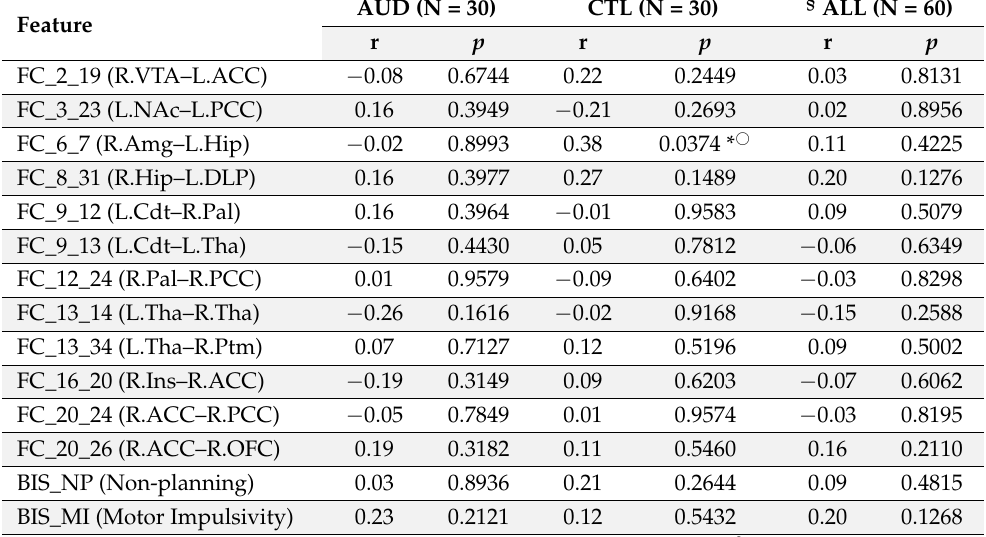
Table 4. Pearson bivariate correlations between the age of the participant and the top significant variables of the RF model. Correlation coefficient (r) and p -values (before Bonferroni correction) are provided for alcohol use disorder (AUD), control (CTL) group, and the total sample (ALL). None of the variables survived Bonferroni correction for multiple comparisons. Zero-order correlations were used for each group separately (N = 30) and partial correlations controlling for group effects were used for the all sample (N = 60).